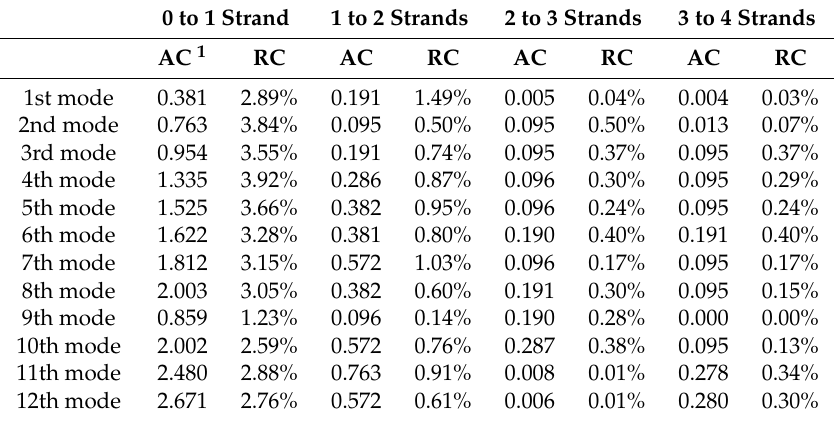
Table 2. Change in natural frequency with the number of broken strands.